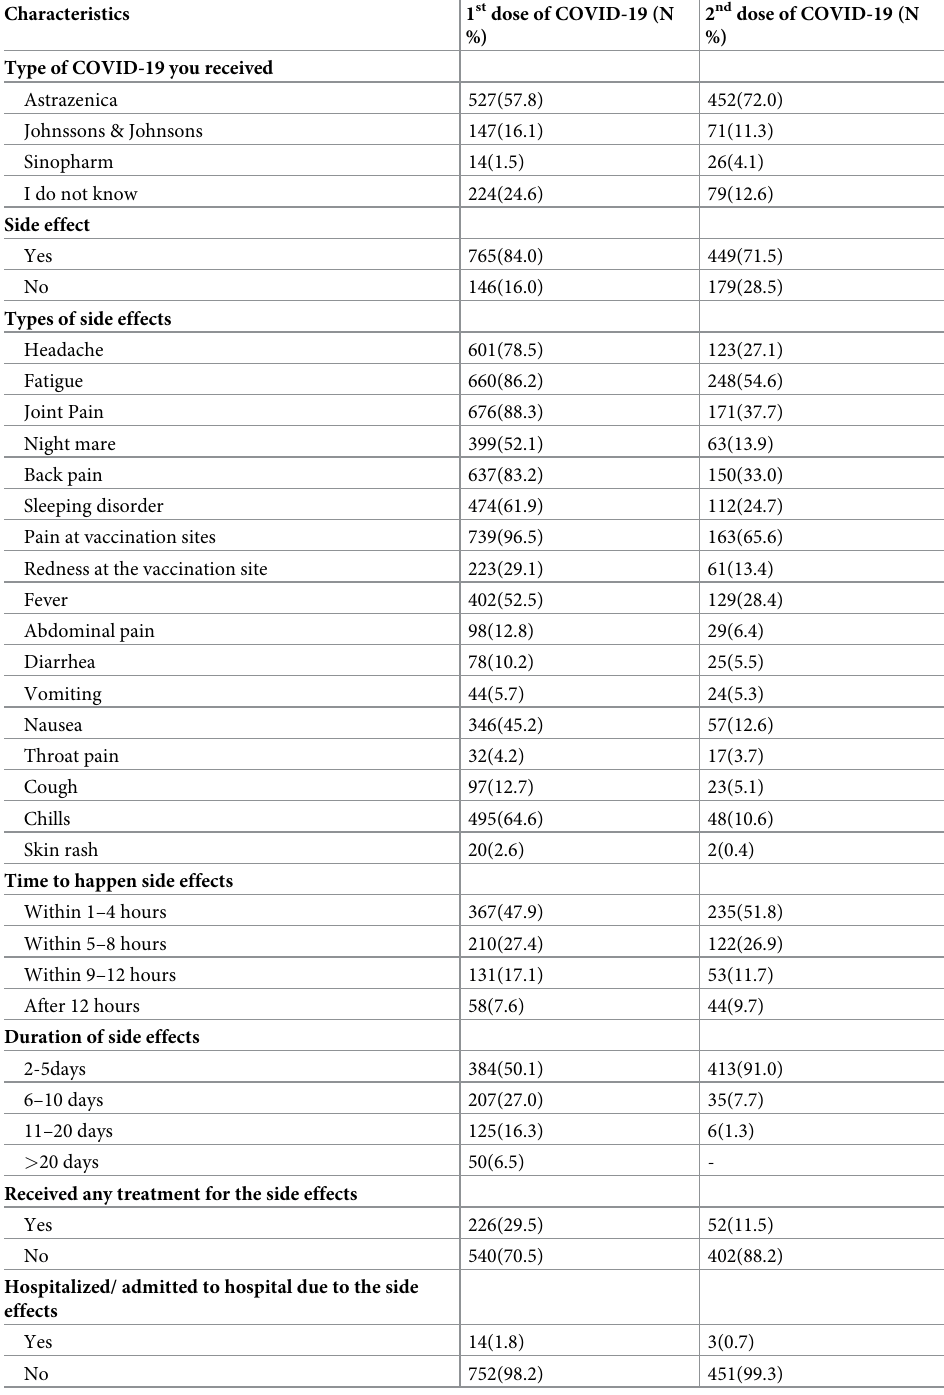
Table 3. Participants self-reported COVID-19 vaccine side effects for the study of post COVID-19 vaccine evalua- tions in Oromia region, Ethiopia, 2021.